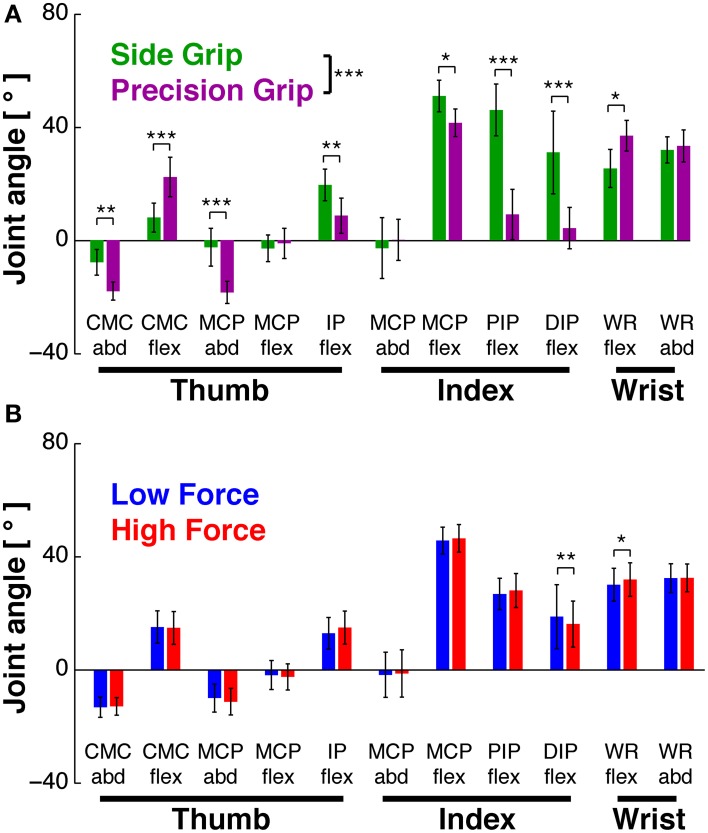
Hand posture as a function of task conditions. Joint angles during Hold, averaged across subjects (mean±95% confidence interval). (A) Joint angles in side (green) vs. precision grip (purple), independent of load condition. GRIP showed a significant main effect (***at legend): 8 of 11 joints showed significant differences in post-hoc tests. (B) Joint angles in low (blue) vs. high load condition (red), independent of grip type. There was no significant main effect of LOAD (but an interaction effect, in which two joints showed a significant difference in post-hoc tests). *At individual joints: significant difference of post-hoc test at p < 0.05, **p < 0.01, ***p < 0.001.